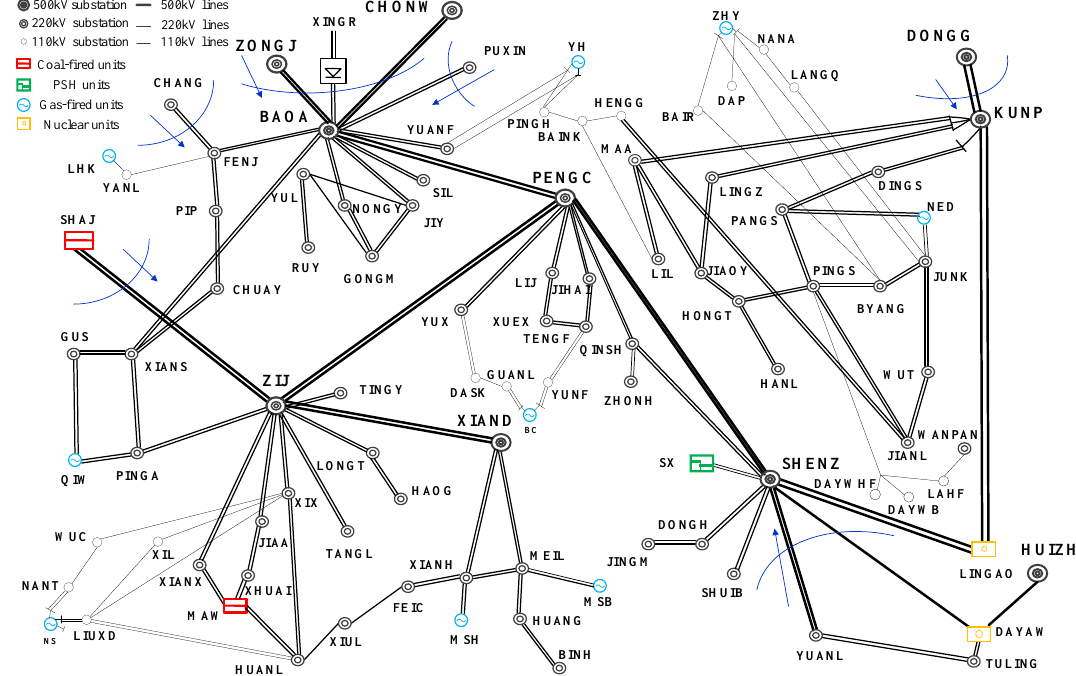
Figure 13. Topology of the main network including several units of 110-kV. Table 9. Parameters of several units.